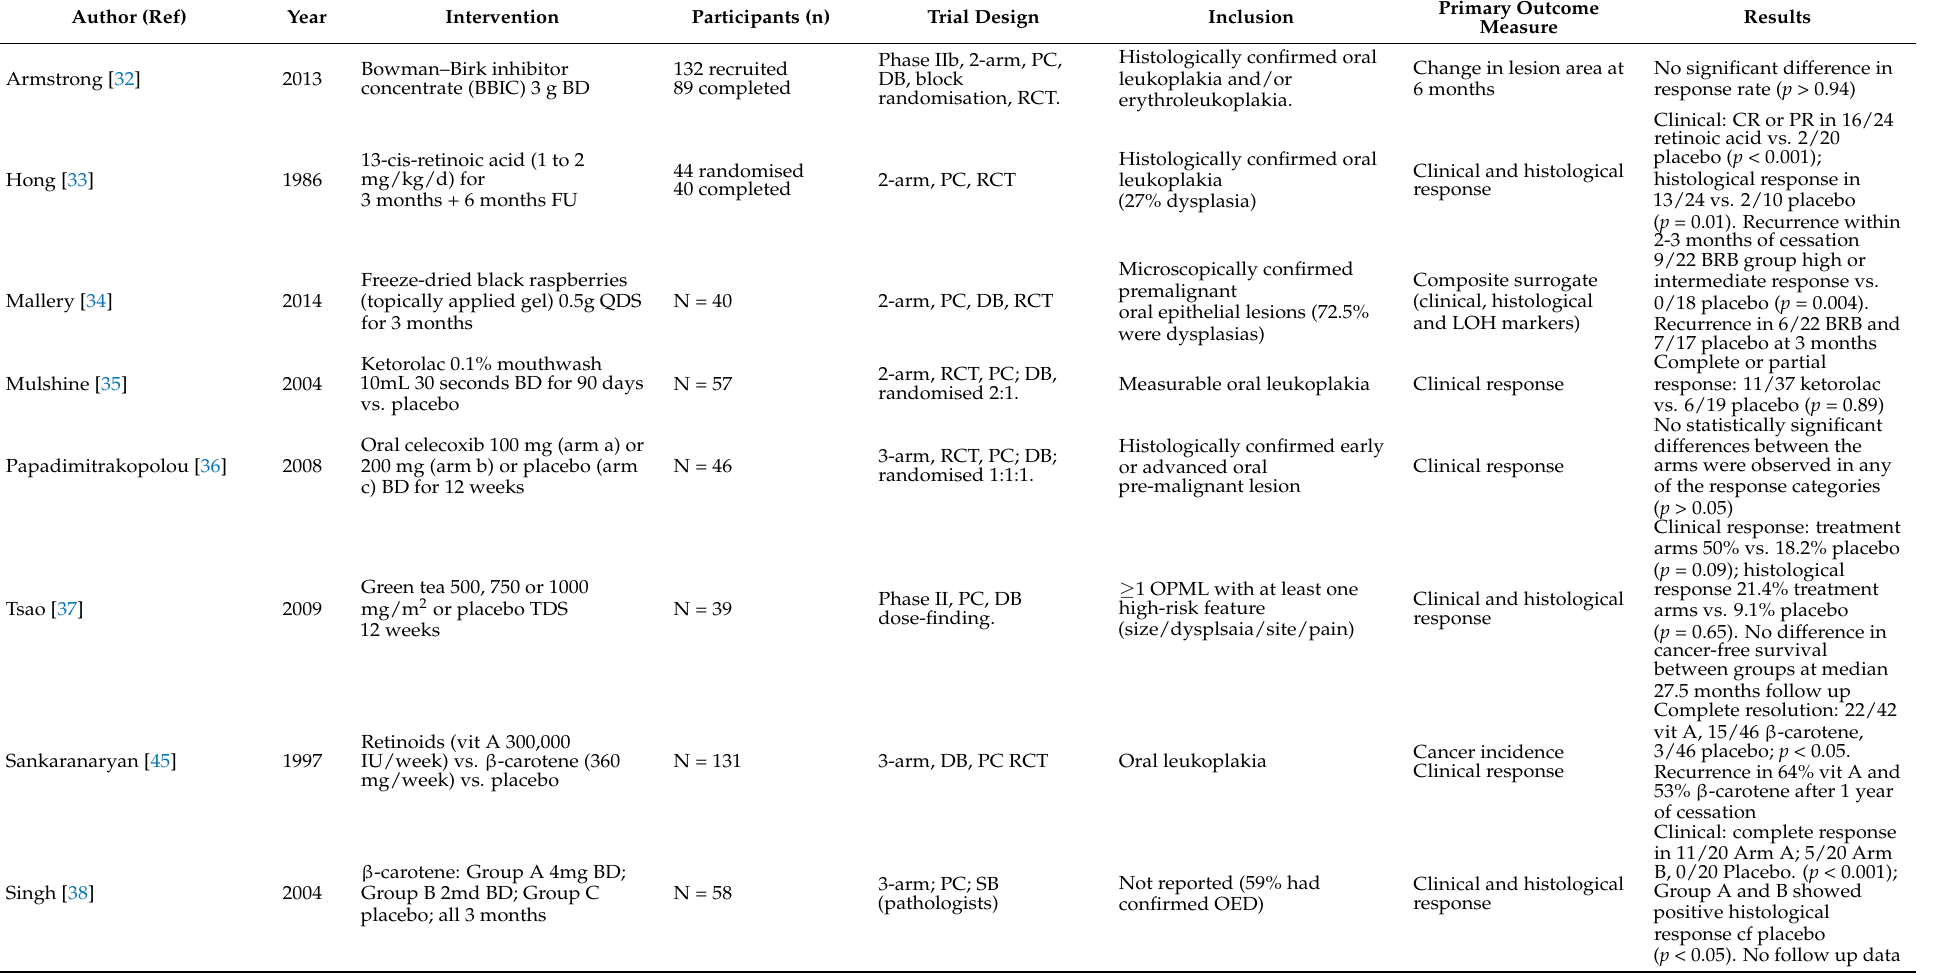
Table 1. Summary of randomised controlled trials from Lodi et al. (Information on number of patients with confirmed OED is reported where this information was available in the published study.) PC—placebo controlled; DB—double blind; SB—single blind; BD—twice daily; TDS—three times daily; QDS—four times daily; OPML—oral premalignant lesion; FU—follow